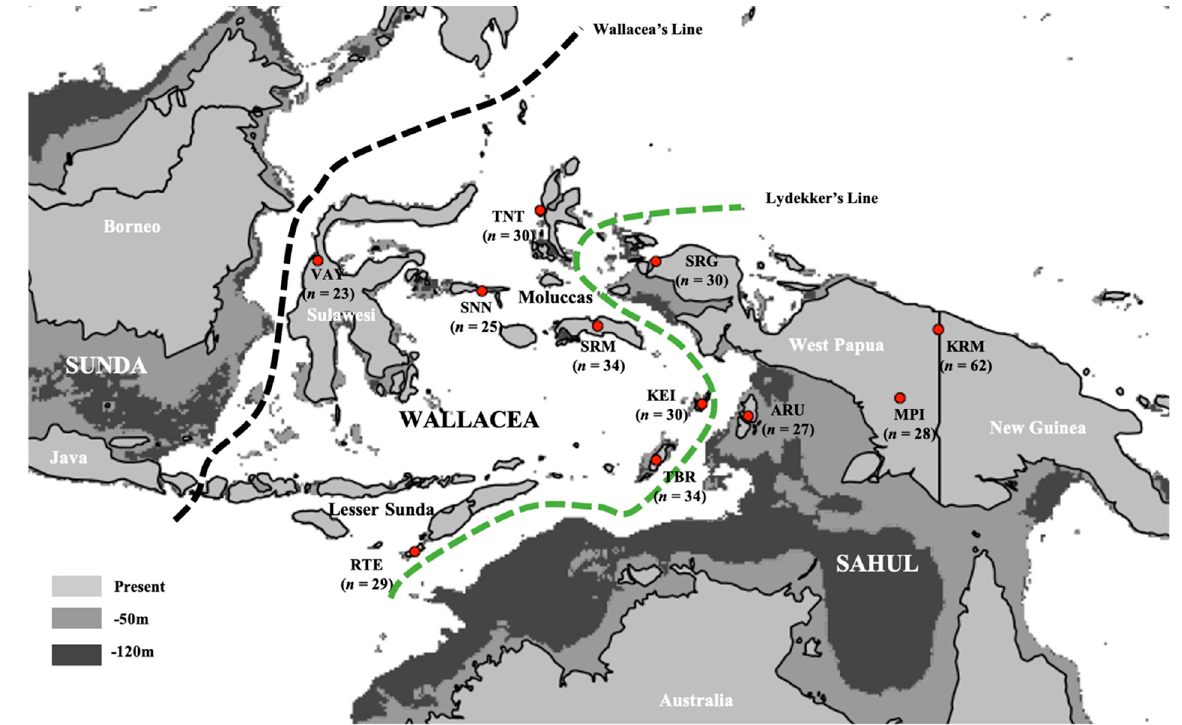
Figure 1. Historical land coverage across study regions and sampling locations of new mitogenomes. Exposed land areas for the Sunda and Sahul continental shelves and the interceding Wallacean islands are shown for the current period (light grey) and inferred for lower sea stands occurring ~65 ka ( − 50 m; medium grey) and ~20 ka ( − 120 m; dark grey) before the current period [13]. The locations of major biogeographic boundaries separating Wallacea from the Sunda and Sahul shelves are shown as black (Wallace’s Line) and green dashed lines (Lydekker’s Line), respectively. Sampling locations (red dots) are indicated by their abbreviated population IDs (see Table S1, Supplementary Materials), with sample size indicated directly beneath.